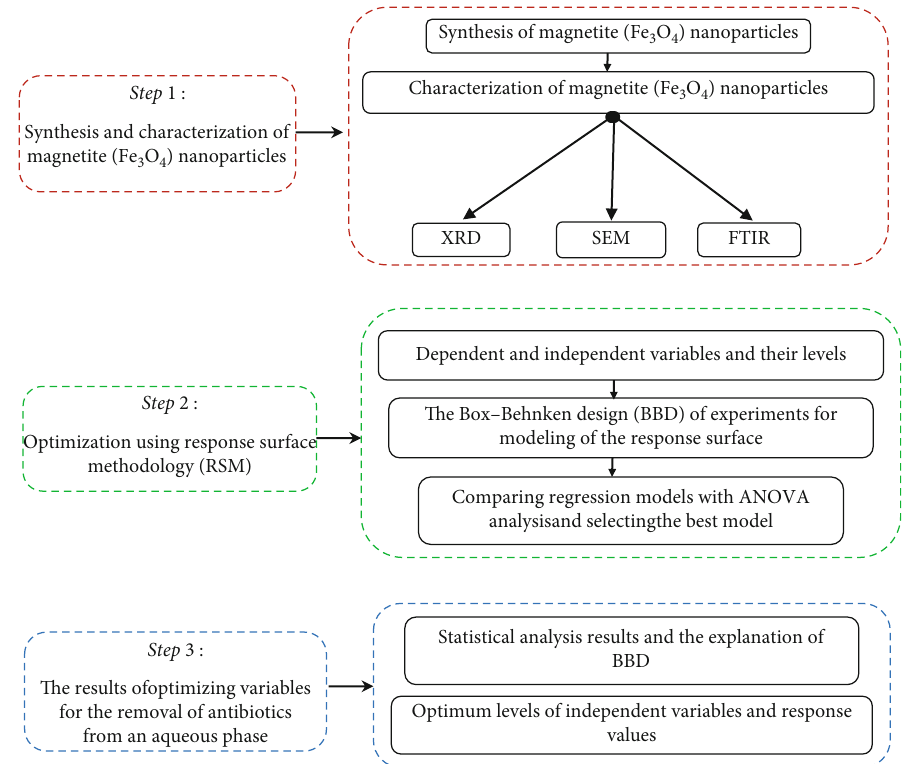
Figure 1: The proposed methodology for optimization of CIP removal by synthesis of magnetite (Fe